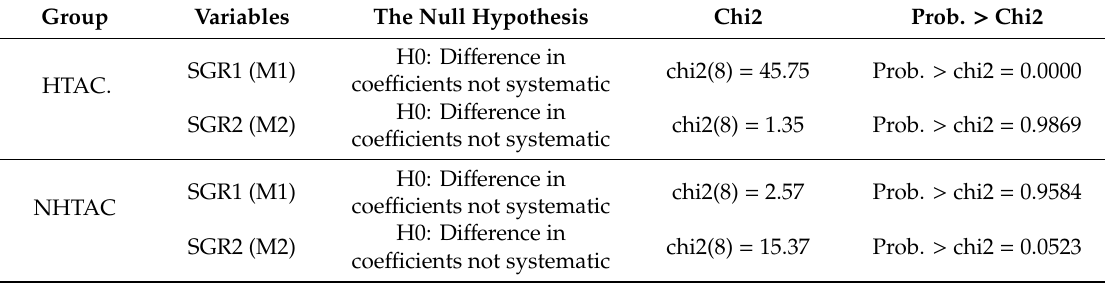
Table 5. Hausman test of